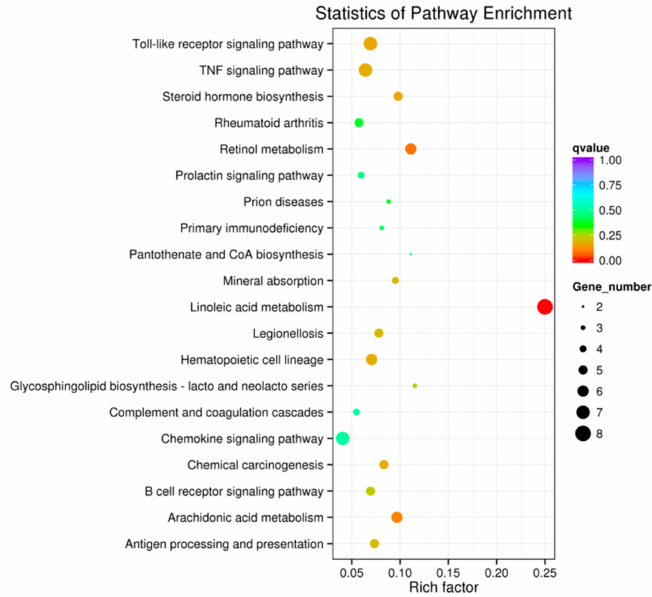
Figure 3. The Kyoto Encyclopedia of Genes and Genomes (KEGG) pathway analysis of differentially expressed genes (DEGs), with the x -axis showing an enrichment factor and the y -axis showing the pathway name; the point size represents the number of DEGs and the point color represents the q -value